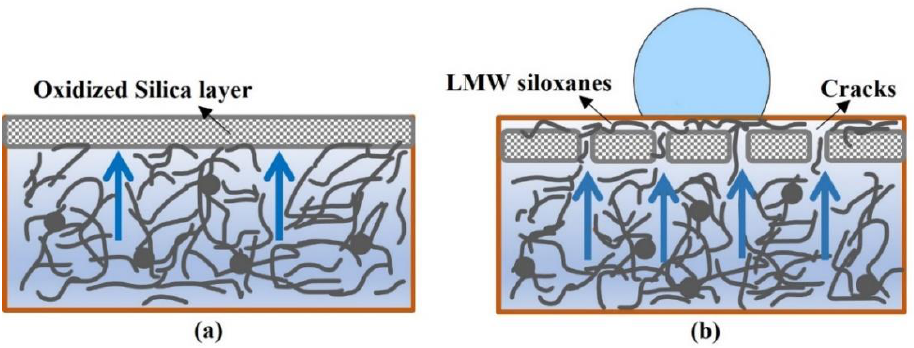
Figure 7. Schematic of mechanisms involved in hydrophobicity recovery of silicone rubber under corona aging ( a ) Silica layer retarding the LMW diffusion ( b ) Cracks in silica layer promoting the LMW migration and covering the silica layer.